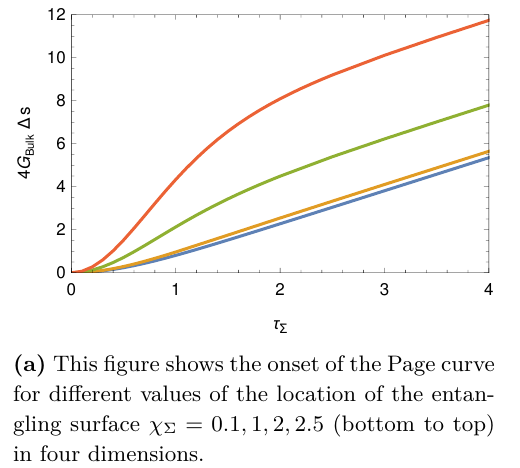
(a) This figure shows the onset of the Page curve for different values of the location of the entan- gling surface χ Σ = 0 . 1 , 1 , 2 , 2 . 5 (bottom to top) in four dimensions. Figure 17. The initial behaviour of the Page curve in four dimensions (left) and a rescaled version of the same plot with bounds (dashed) on the onset